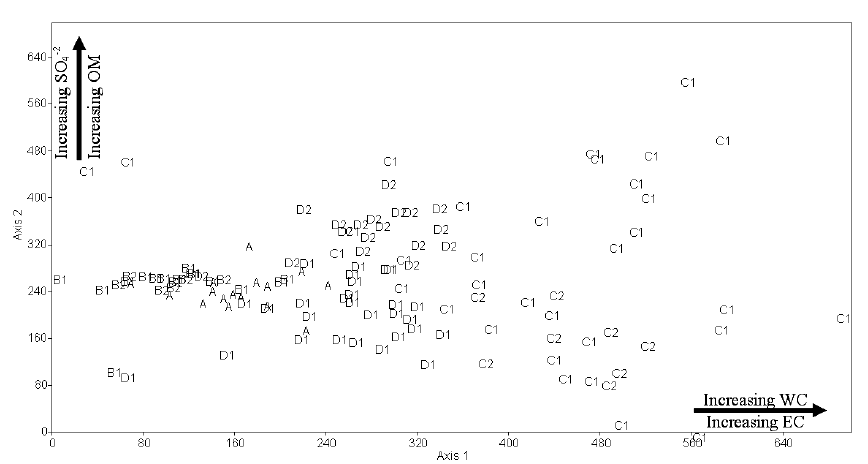
Fig. 4 . First two axes of the DCA ordination of 142 stands with the 7 vegetation groups (A-D2) separated by cluster analysis